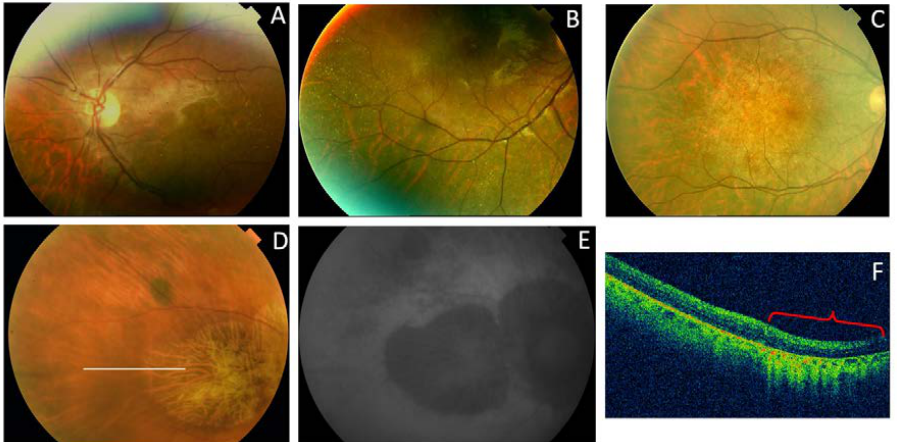
Figure 14. The clinical appearance of family 5c (p.Arg195Leu). ( A ) The posterior pole and ( B ) mid-periphery from F5c-VI-2 had very small whitish dots. ( C ) F5c-V-2 had a more advanced appearance. ( D ) F5c-IV-4 had macular atrophy consistent with the diagnosis of CACD, with evident atrophy in the ( E ) AF and ( F ) SC-OCT (red brace) images.